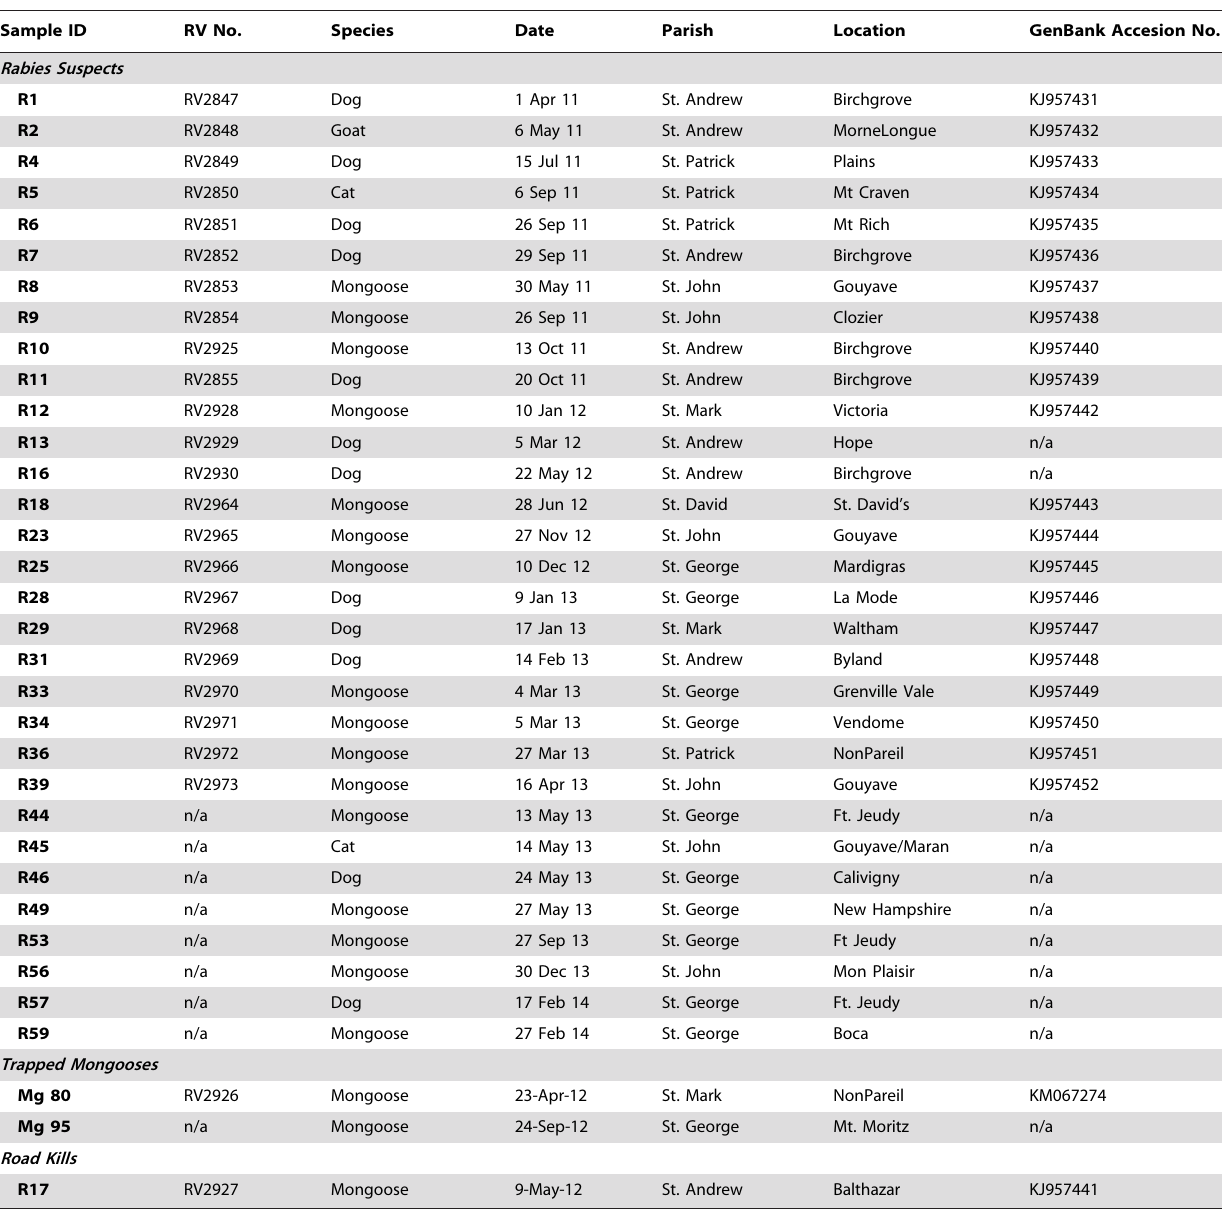
Table 1. Rabies virus positive animals from Grenada from April 2011 to March 2014.